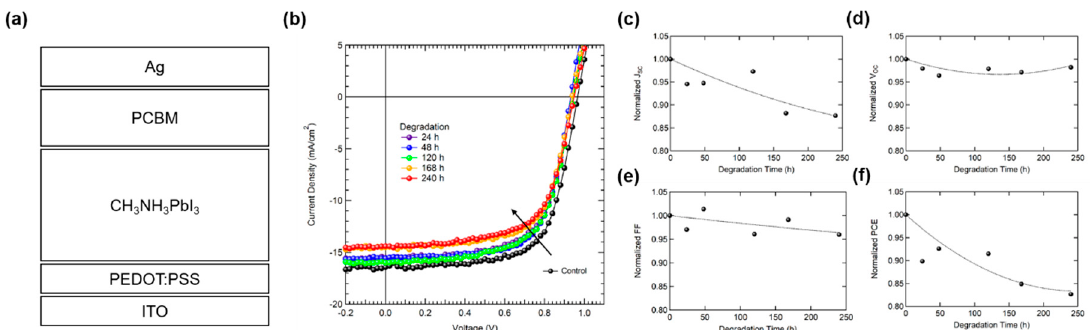
Figure 1. ( a ) Device structure of PSCs ( b ) J – V curve for each device degradation points under 1 sun condition. Devices were stored in ambient air without any light exposure during device degradation Table 1. Photovoltaic parameters of PSCs regarding degradation time. time. Normalized decay trends of each photovoltaic parameter ( c ) J SC , ( d ) V OC , ( e ) FF and ( f )